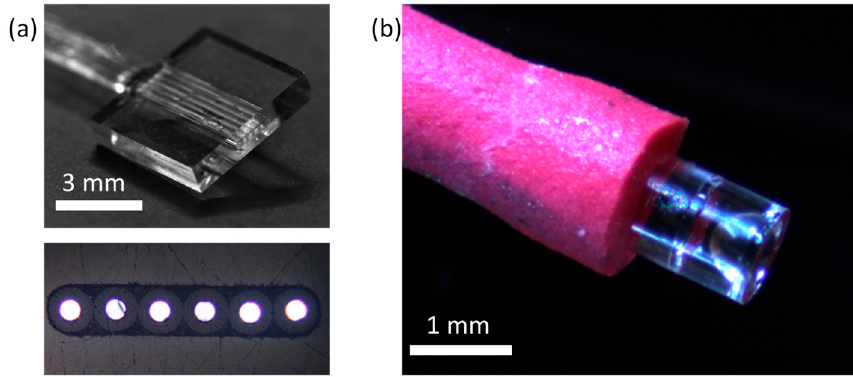
Figure 6. ( a ) At the proximal end, the return fibres (shown here with 50 µ m diameter cores), were re-arranged into a linear array using an ultrafast laser-assisted etching (ULAE)-fabricated precision slot for efficient interfacing with traditional spectrometers. ( b ) A micrograph of the assembled distal end with heat-shrink tubing added for protection.